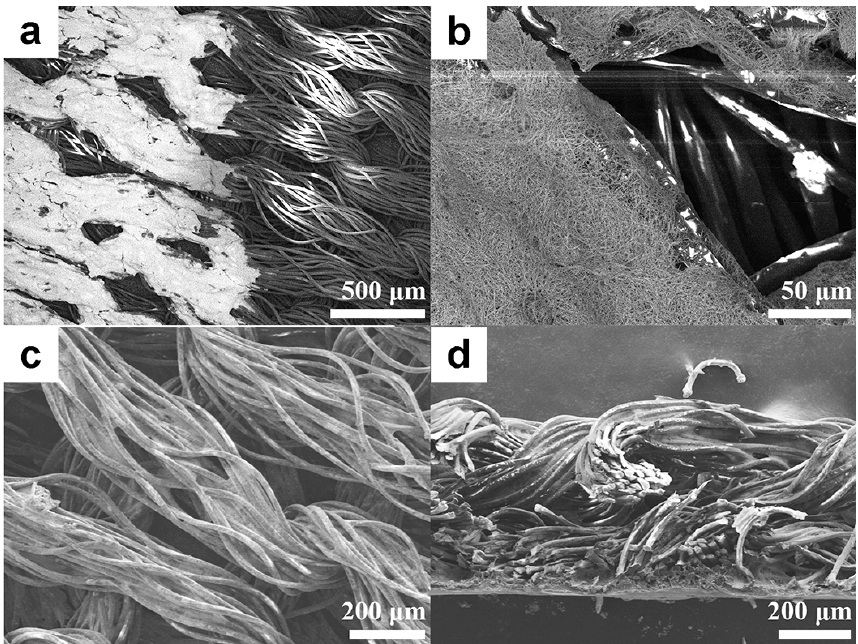
Figure 4. The SEM image of the interface between printed and un-printed areas ( a ), SEM image of the defect of printed area at the beginning area of printed tracks ( b ), top-view ( c ) and cross-view ( d ) SEM images of the textile electrode.